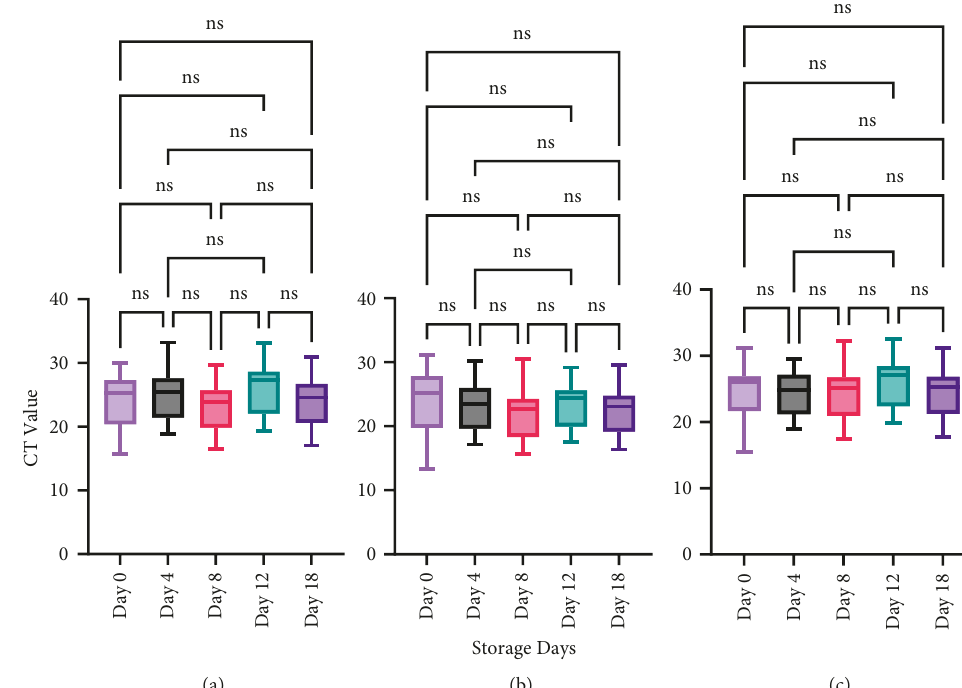
Figure 3: CTvalue of target genes for the stability test at room temperature ( ± 25 ° C). CTvalues of samples stored for 0 days, 4 days, 8 days, 12 days, and 18 days at room temperature ( ± 25 ° C): (a) ORF1ab; (b) N-gene; and (c) E-gene. ns—not statistically significant. P -value > 0.05 is considered not statistically significant.